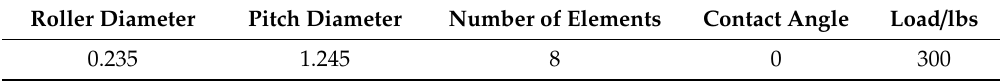
Figure 7. The rolling bearing with inner race fault. Table 1. The structure parameter of rolling